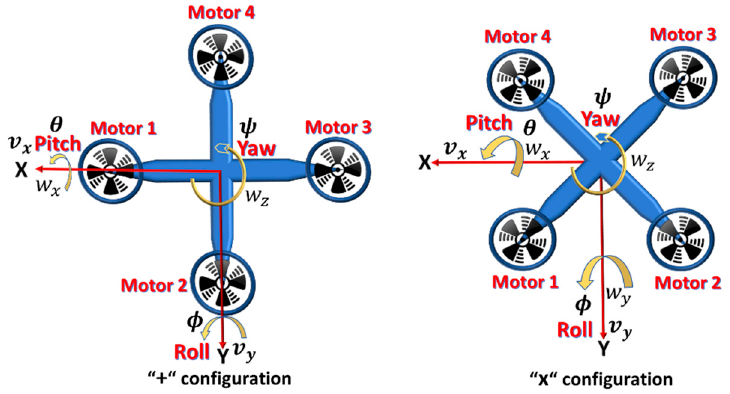
Figure 4. The quadcopter typically employs two configurations either plus or X.